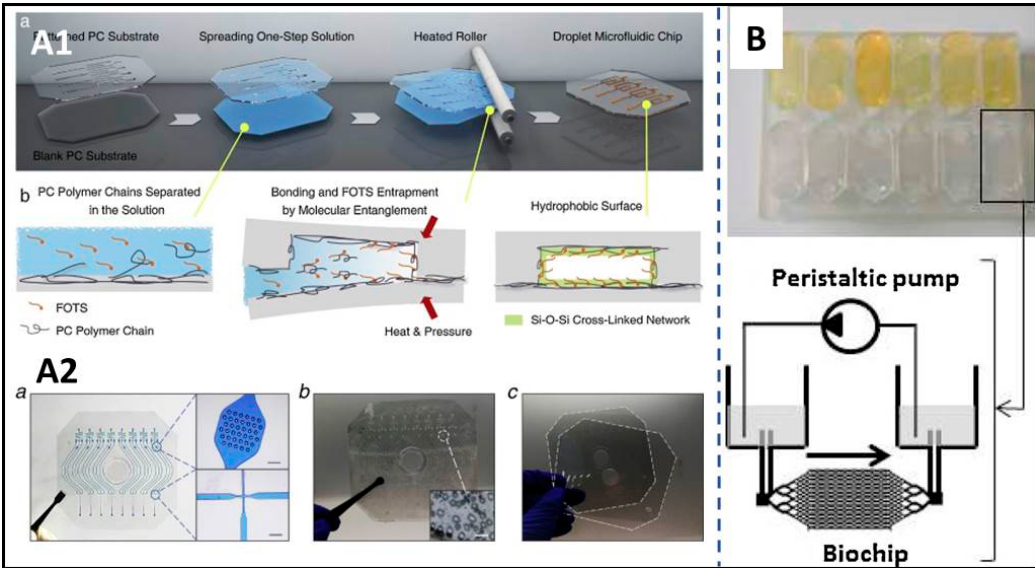
Figure 1. Two exhibitions of diverse materials are used to create a microfluidic system with high throughput. ( A1 , A2 ) A polycarbonate-based droplet microfluidic chip was fabricated by one-step bonding and hydrophobic surface modification, reproduced with permission from [40]. ( B ) Perfluoropolyether (PFPE) and polydimethylsiloxane (PDMS) connected under the integrated dynamic cell cultures in microsystems (IDCCM) bottom layer to fabricate a fluorinated microfluidic biochip to culture liver and kidney cells, reproduced with permission from